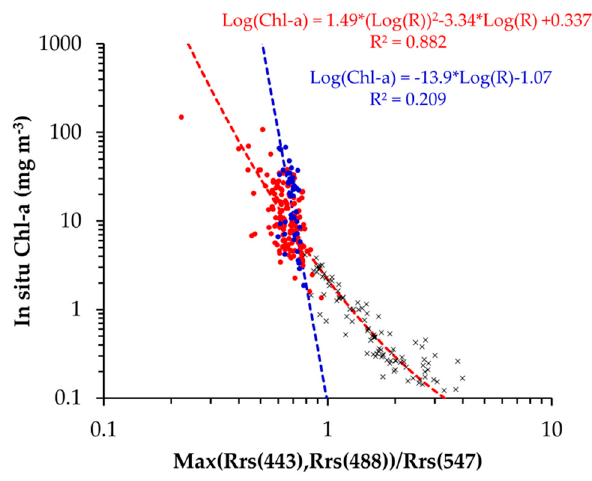
Figure 8. Relation between in situ Chl-a and max(Rrs443, Rrs488)/Rrs547 (R). Red and blue symbols represent the subsets of non-turbid and turbid waters, respectively, from Ariake Bay. The dashed lines with lower and higher slope represents the regression for non-turbid waters and turbid waters, respectively. The equations of the second order polynomial and linear regressions represent the switching algorithm for non-turbid and turbid waters, respectively.